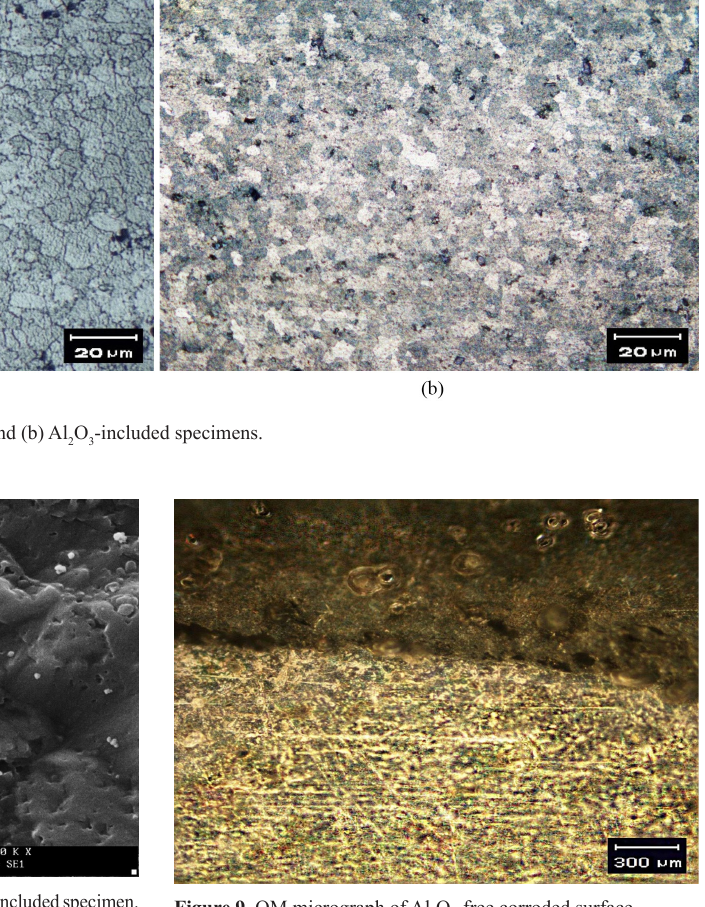
Figure 9. OM micrograph of Al